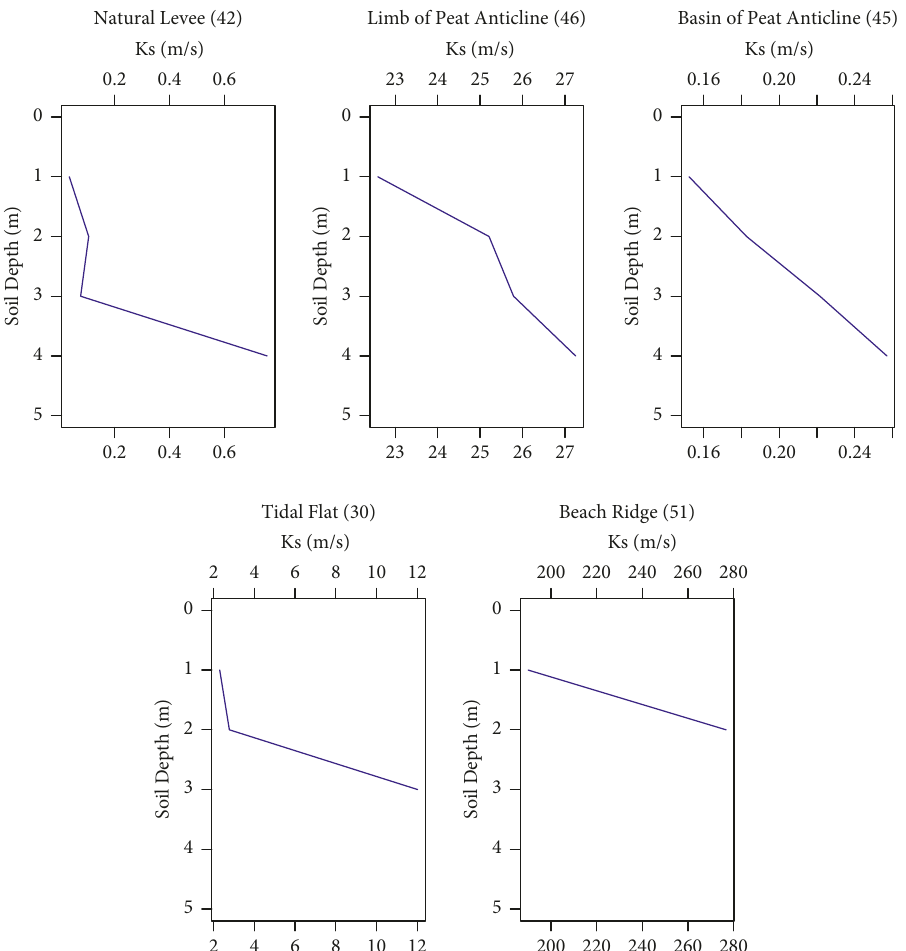
Figure 9: The values of K s profile along soil depth in different landforms in Barito Delta applying Saxton and Rawls